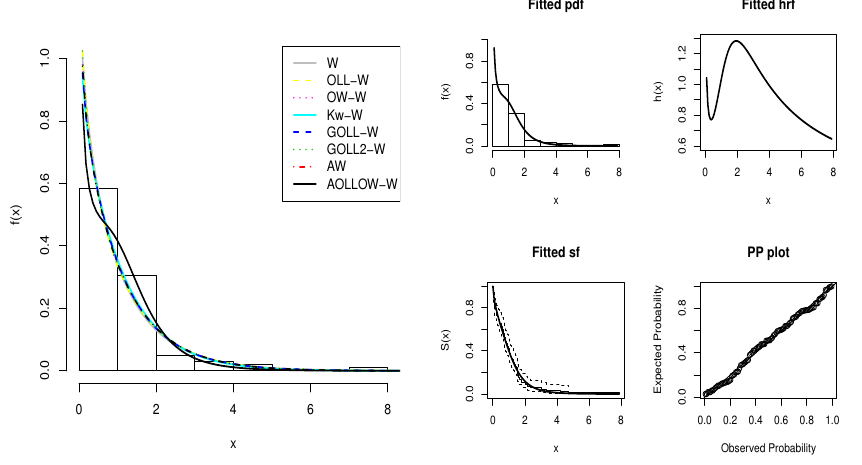
Figure 8. The fitted plots for the first dataset.